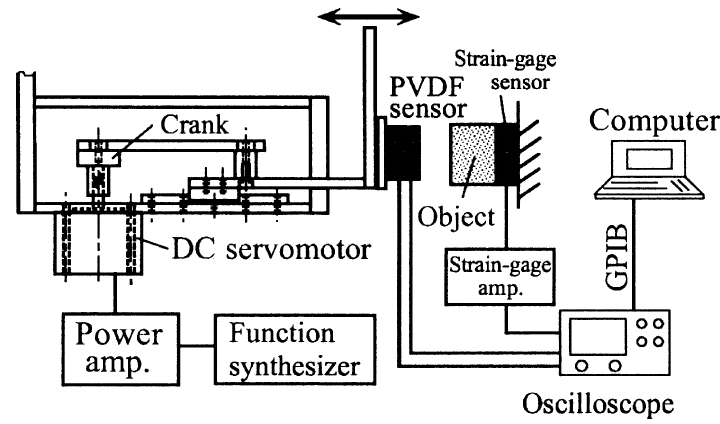
Fig. 2. Experimental setup for measuring fundamental characteristics of sensor.